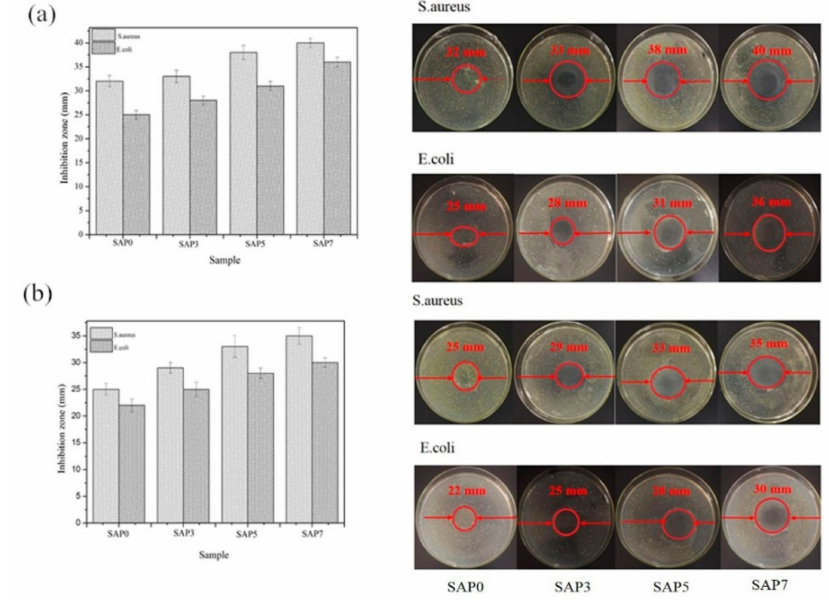
Figure 7. The antibacterial activity of the samples ( a ) and the dried samples after swollen in distilled water ( b